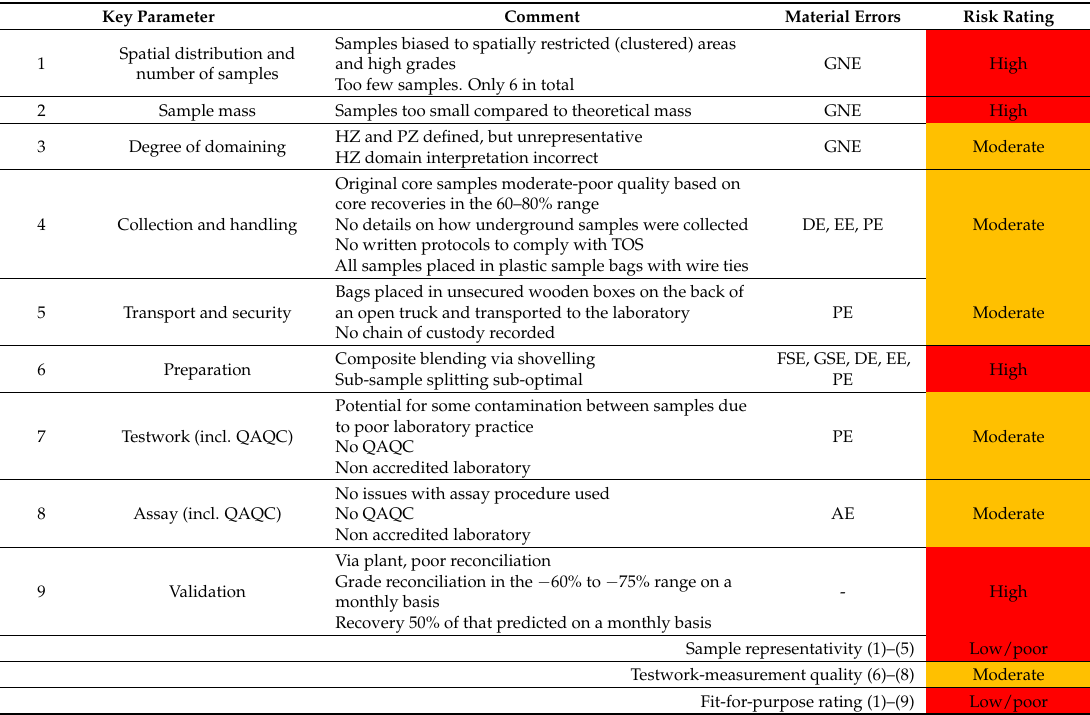
Table 24. Risk review of metallurgical sampling and testwork for case study original programme.